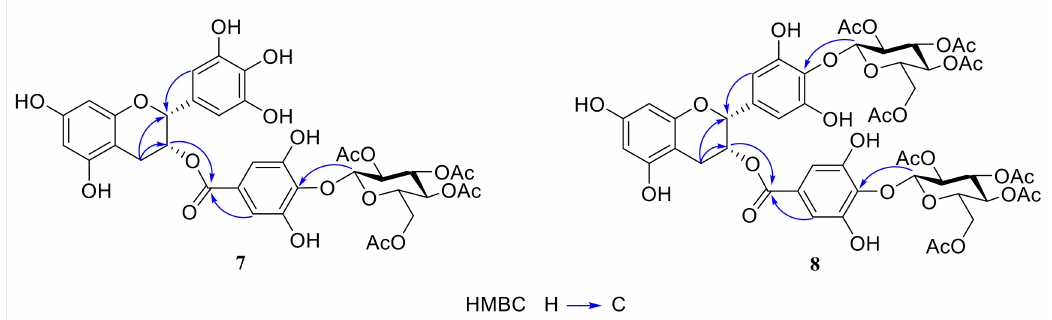
Figure 2. HMBC correlations in compounds 7 and 8 .